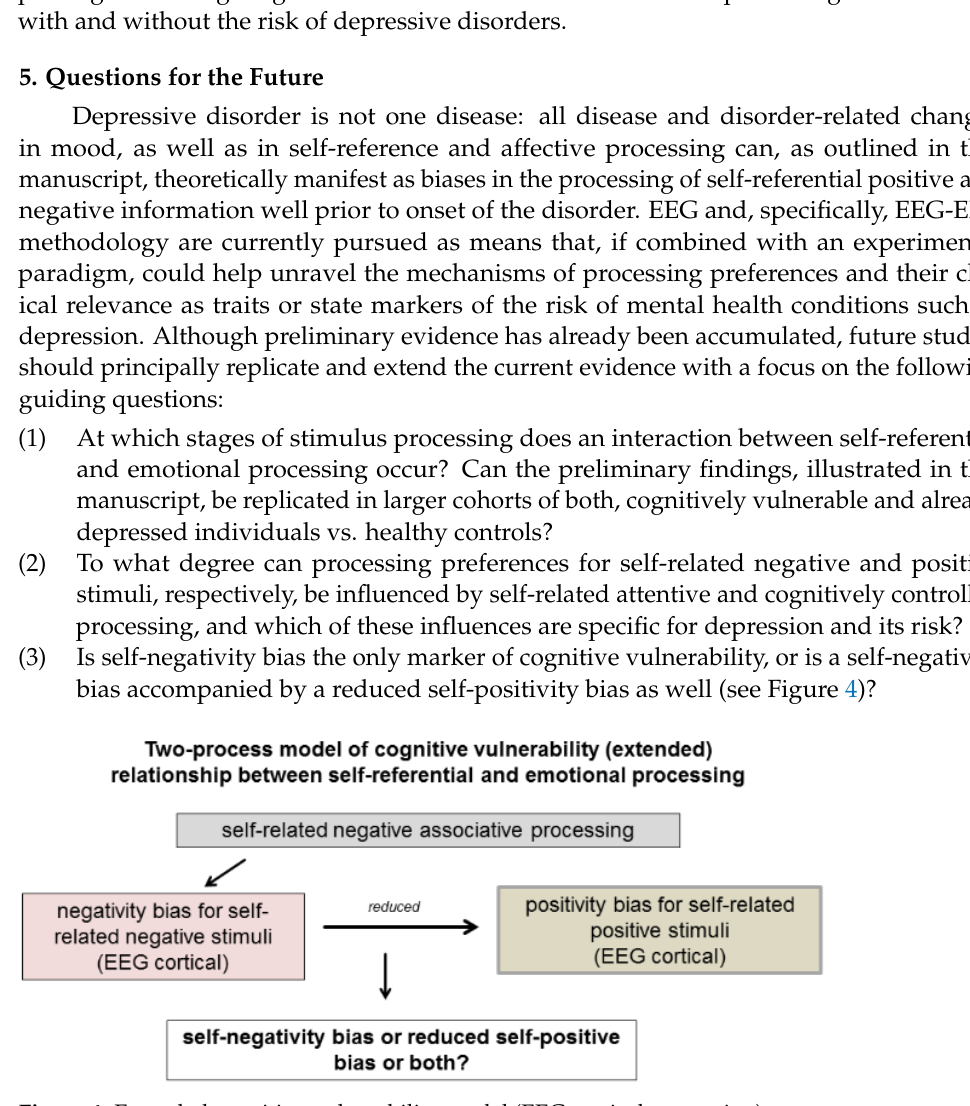
Figure 4. Extended cognitive vulnerability model (EEG cortical processing).